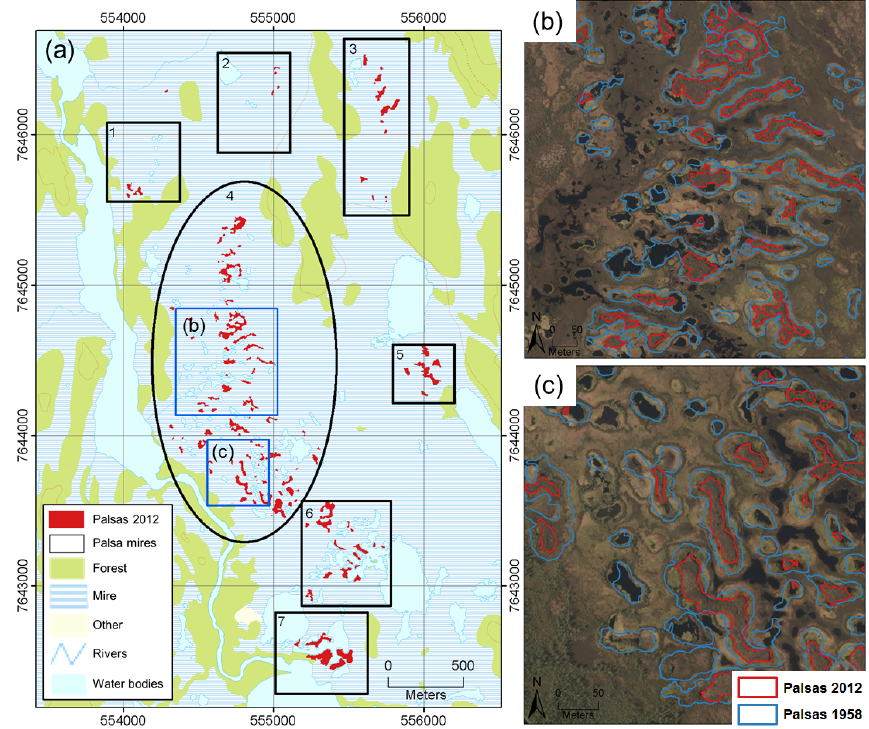
Figure 10. (a) Palsas mires mapped in the study area Goatheluoppal. Background map from Kartverket (2015b) with projection in UTM 35N. The images in (b) and (c) show examples of some palsas mapped in the palsa region 4 in Goatheluoppal. To increase the visibility of this figure, only the delineation of palsas from 1958 and 2012 is included. Background images from 2012 through Norgeibilder (2015).